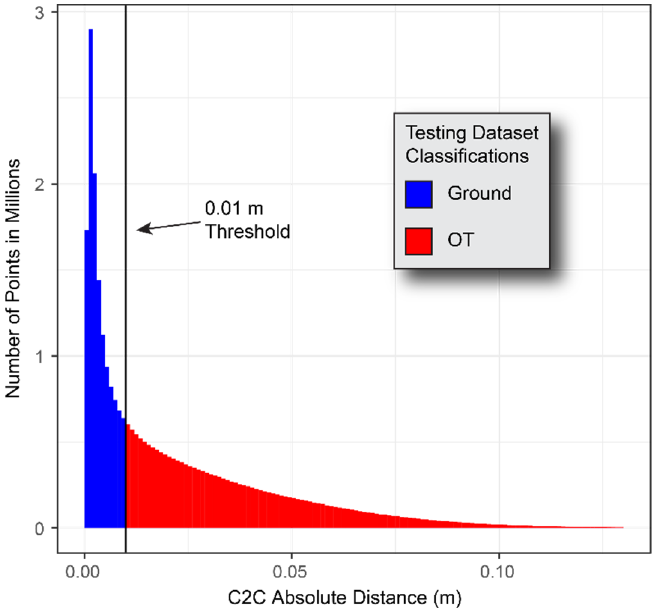
Figure 6. Histogram showing the C2C absolute distances between each point in the vegetated June 3D point cloud and its corresponding nearest point in the bare July 3D point cloud.